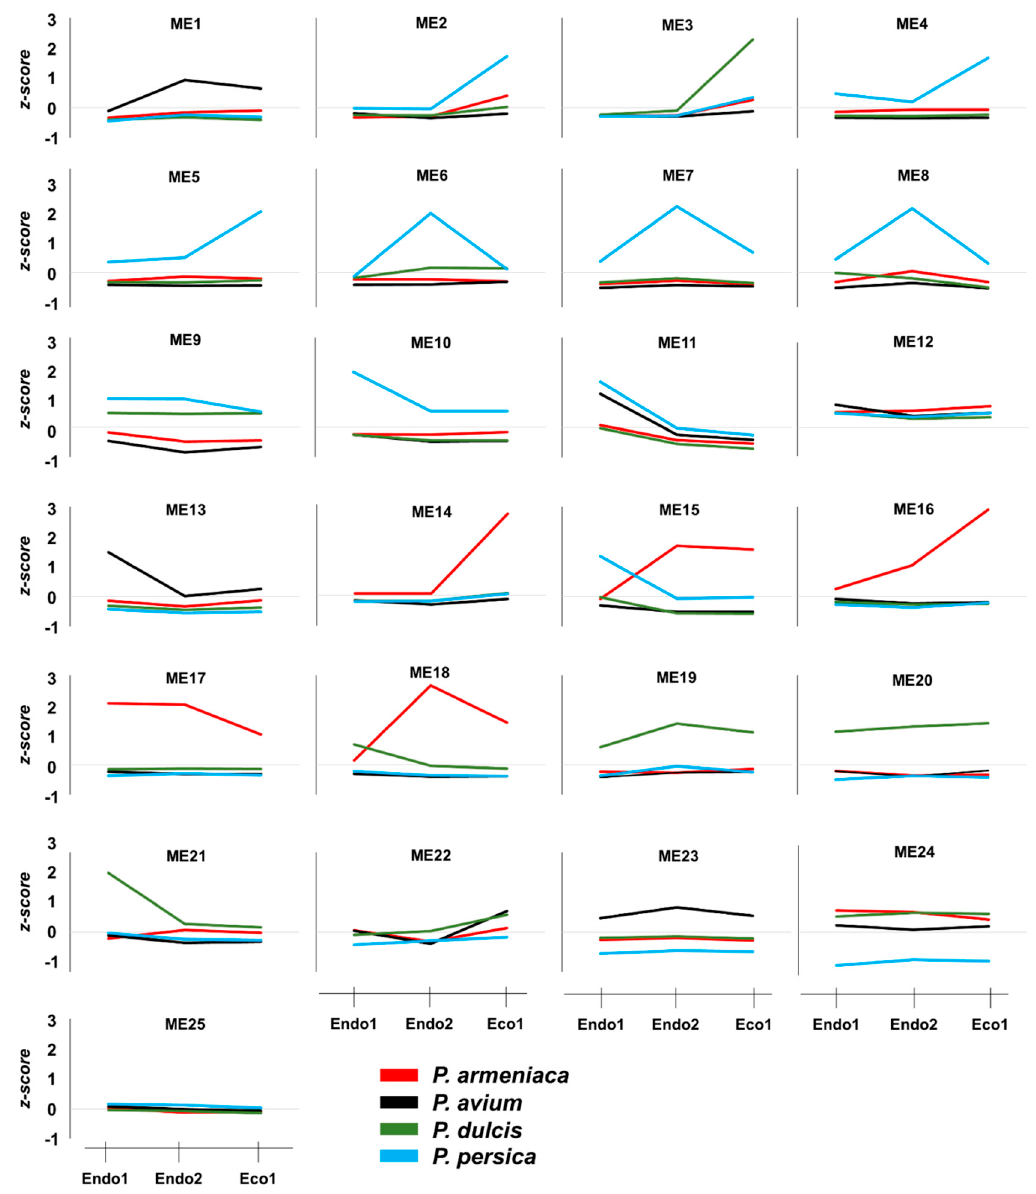
Figure 5. Average z − scores per species for each module from the integrated co-expression network.